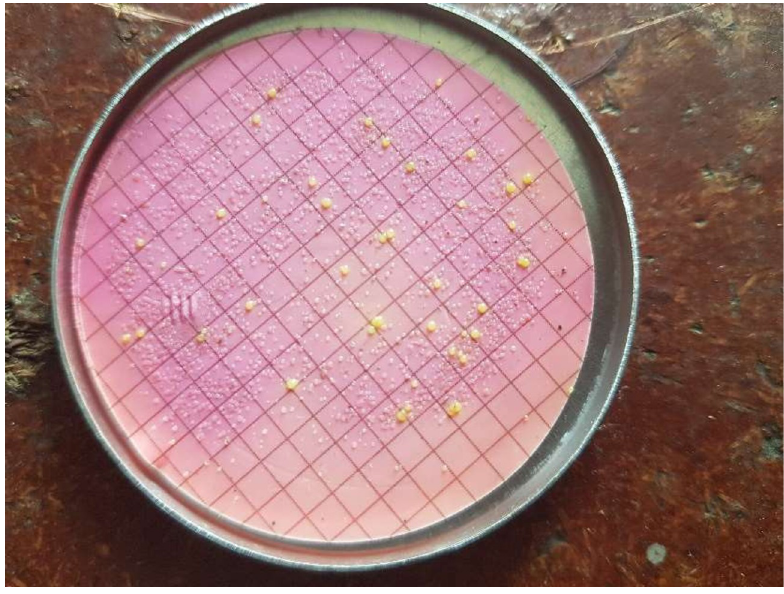
Fig 5. Growth of the thermotolerant microorganisms using membrane filter technique in water samples in Amhara and Afar regions of Ethiopia.